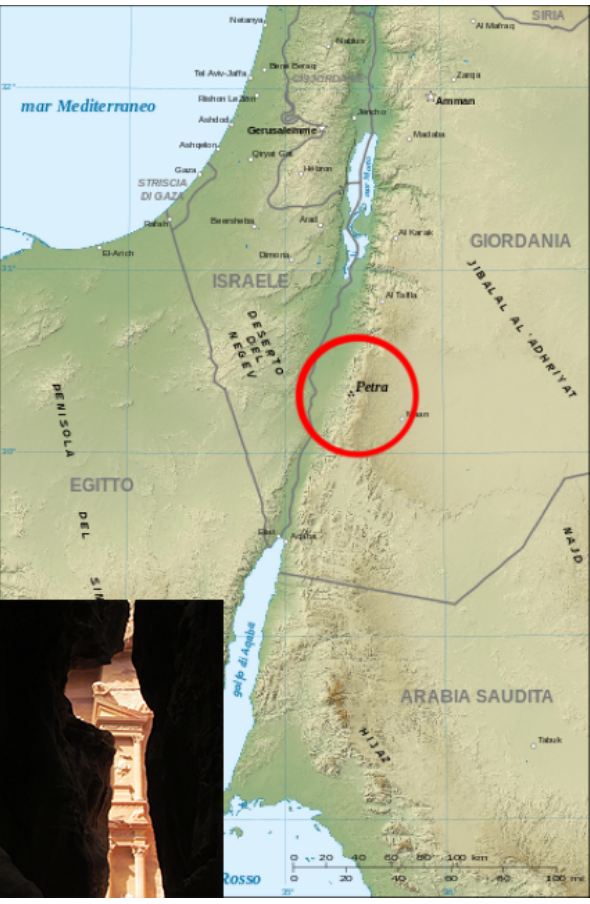
Figure 2. The geographical localization of the archaeological site with a frame of the throat leading to